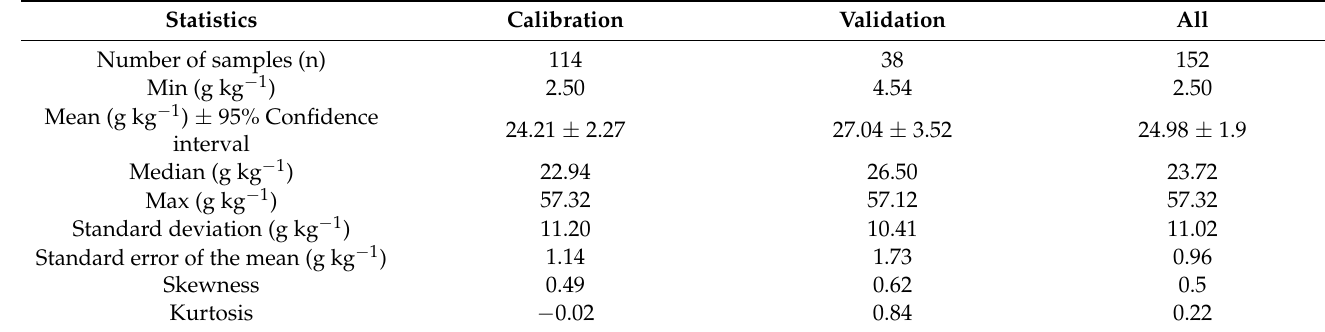
Table 3. Descriptive statistics of the soil organic carbon content (g kg − 1 ) in the calibration and validation datasets.